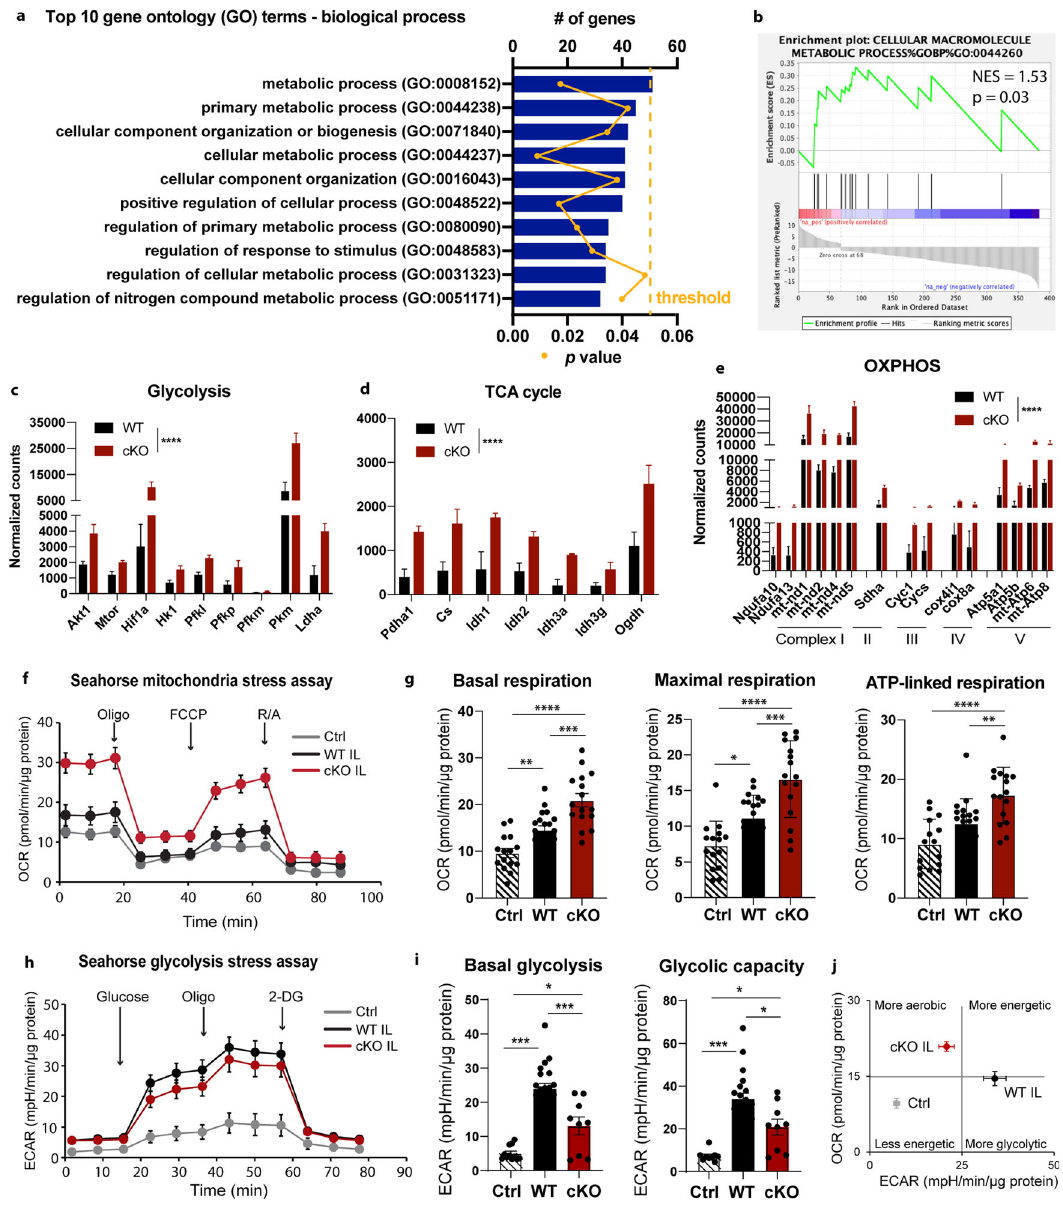
Fig. 5 Nhe1 cKO microglia showed accelerated oxidative phosphorylation and ATP-linked respiration. a – b Top 10 Gene Oncology terms in biological process, and Gene Set Enrichment Analysis analyzed with DEGs from Fig. 2D. c – e Transcriptome analysis of genes relating to glucose metabolism processes, including glycolysis, TCA cycle, and oxidative phosphorylation. N = 3 animals. f – g Oxygen consumption rate (OCR) measured by mitochondrial stress test using Seahorse Extracellular Flux Analyzer in isolated P2RY12 + microglial cells. As we observed similar results in non-lesion CL hemispheres from WT and cKO brains, these samples were pooled to represent as the non-lesion control (Ctrl). N = 15-20 measurements, from 3-4 independent experiments. h – i Extracellular acidi fi cation rate (ECAR) measured by Seahorse Extracellular Flux Analyzer in isolated P2RY12 + microglial cells. CL hemispheres from WT and cKO were pooled as the non-lesion control (Ctrl). N = 9-20 measurements, from 3 independent experiments. j Snapshot